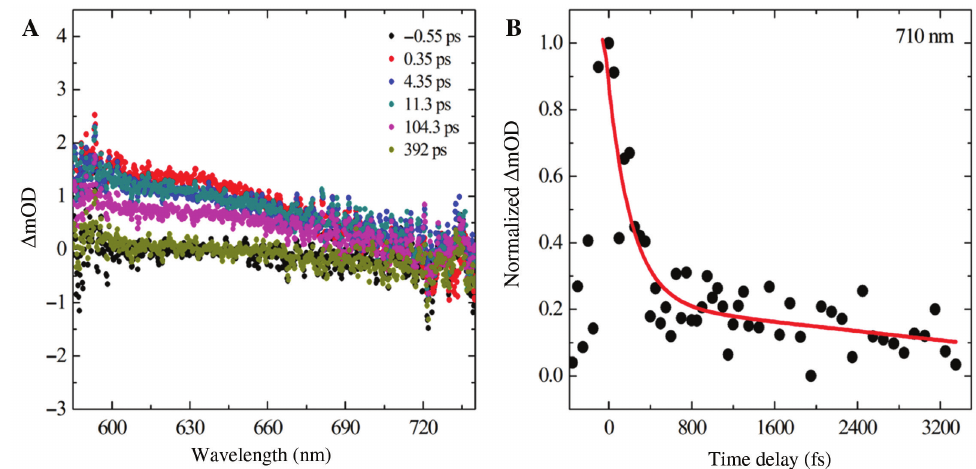
C T . 3 2 x C T 3 2 x